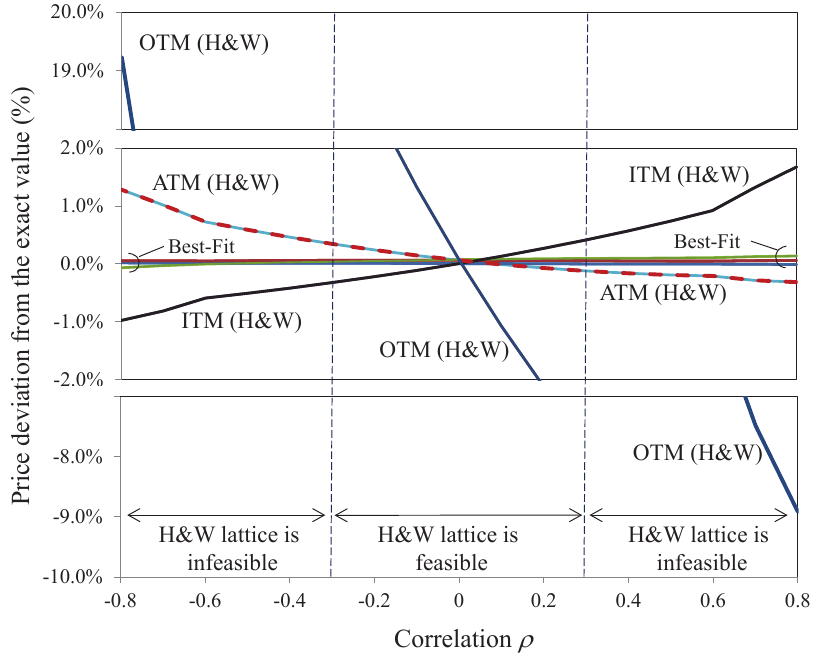
Figure 2. Deviation (%) of the values of European call options from the exact ones using Best-Fit and H&W for branching